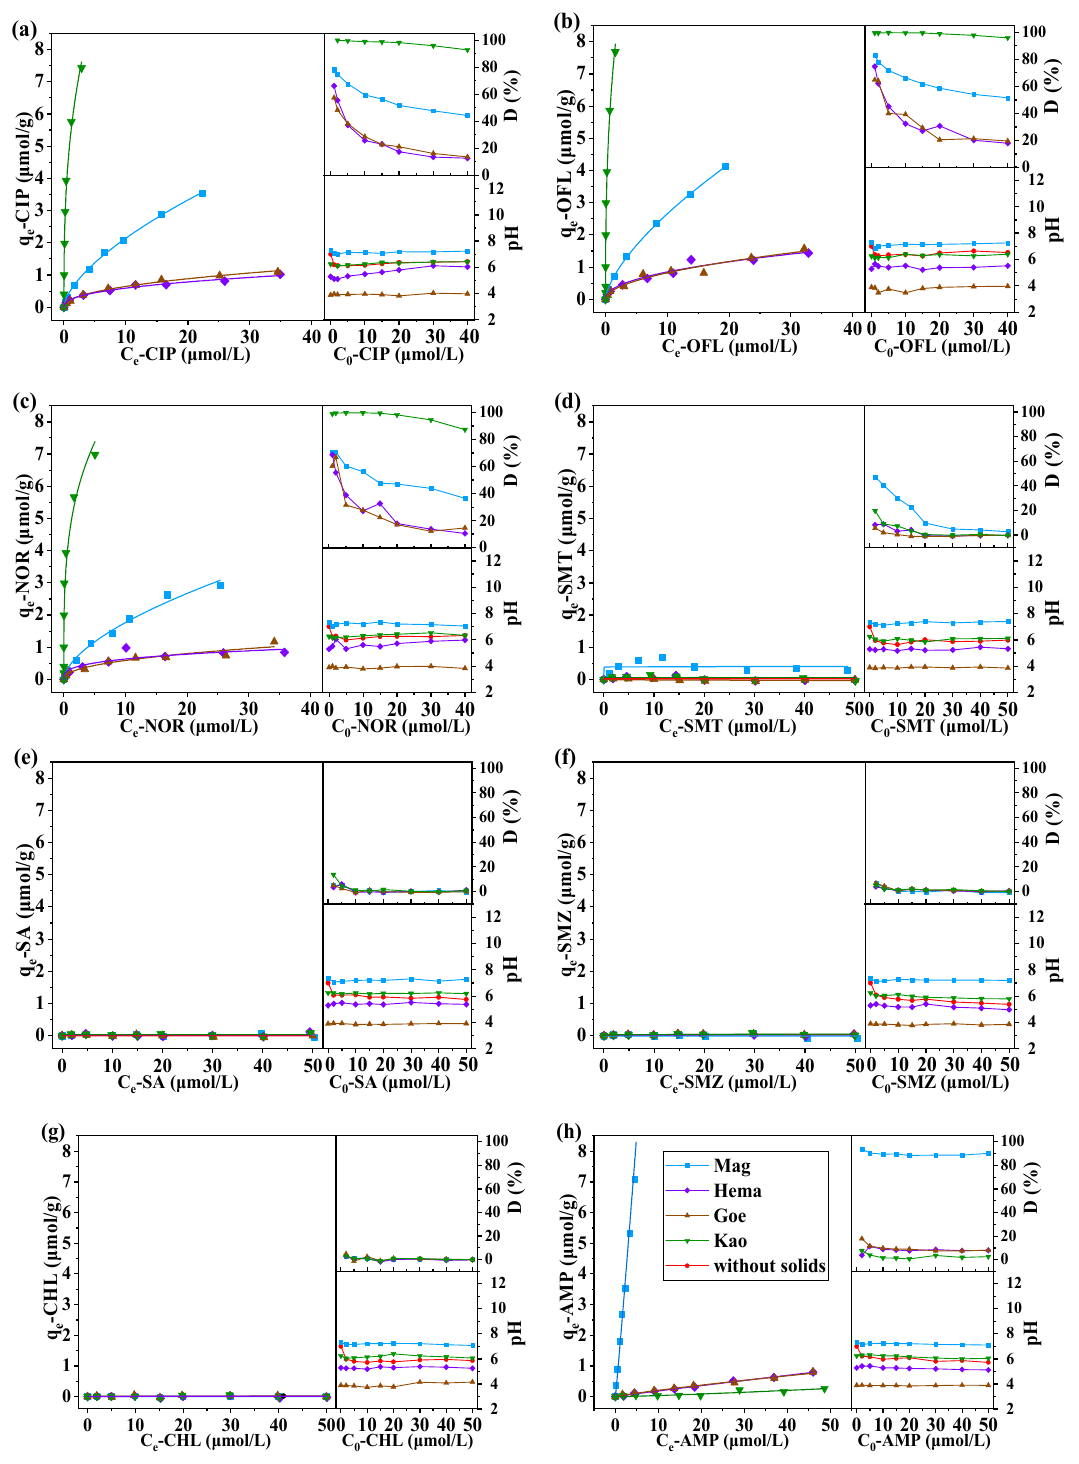
Figure 4. Adsorption of ( a ) CIP, ( b ) OFL, ( c ) NOR, ( d ) SMT, ( e ) SA, ( f ) SMZ, ( g ) CHL, and ( h ) AMP on iron-containing minerals. Conditions: dosage of solids = 5 g/L. Table 2. Fitted parameters for different antibiotics adsorption isotherms.